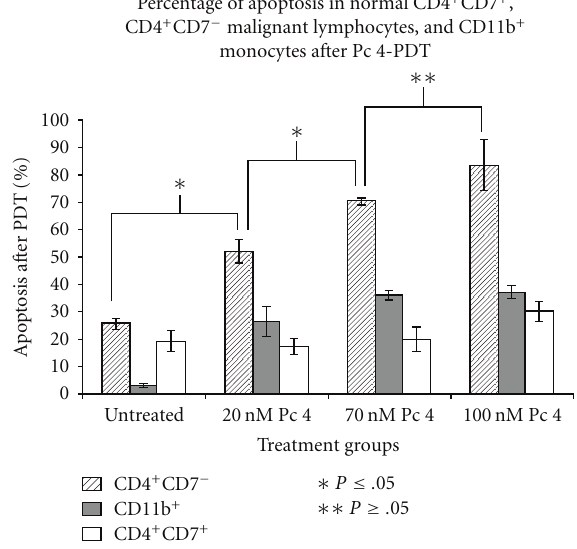
Figure 1: Pc 4-PDT dose response for the induction of apoptosis in CD4 + CD7 − malignant lymphocytes, CD4 + CD7 + normal lympho- cytes, and CD11b + monocytes of patients with Sezary syndrome. Peripheral blood mononuclear cells (PBMCs) were isolated by Ficoll-histopaque centrifugation and then treated with Pc 4 at 0– 100 nM followed by photoirradiation (200 mJ/cm 2